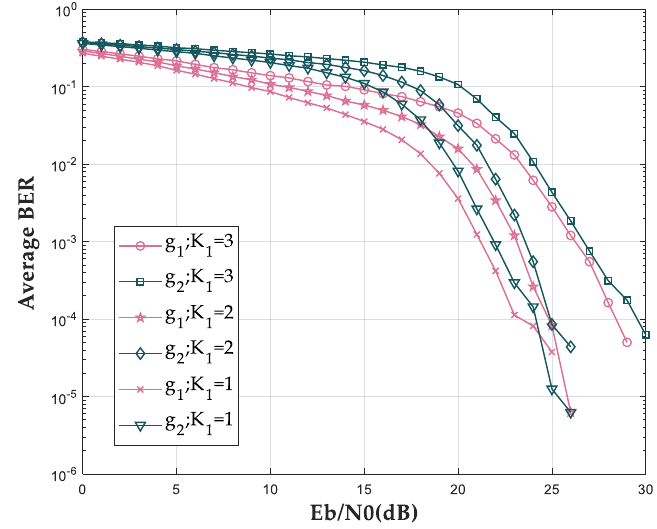
Figure 18. Impact of different K